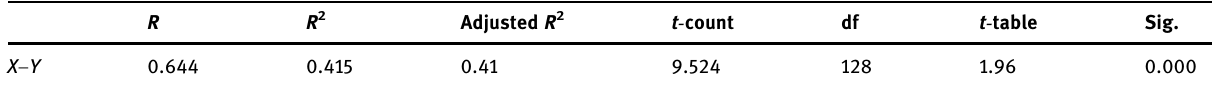
Table 7: Summary of regression analysis